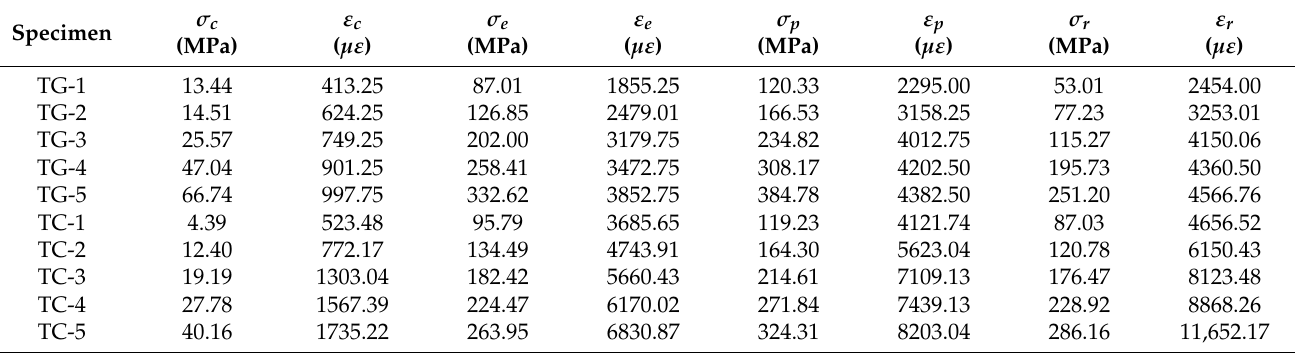
Table 4. Statistical table of mechanical parameters.